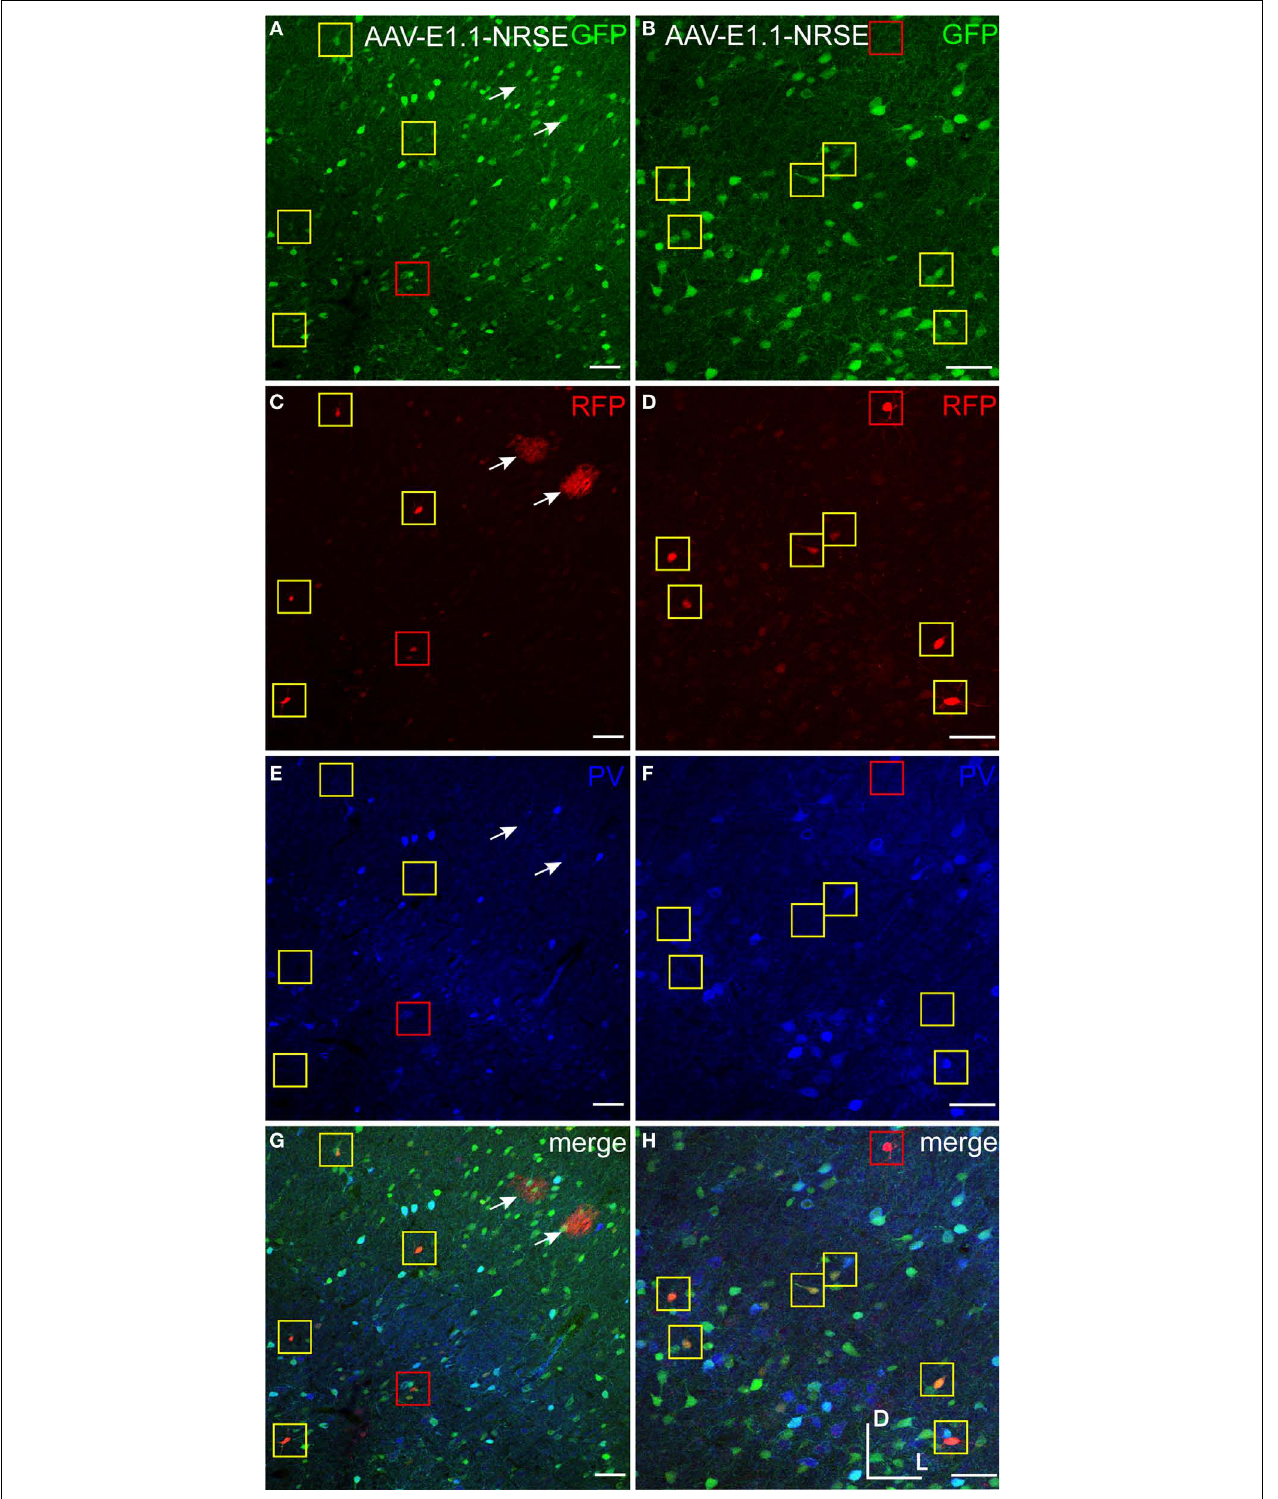
FIGURE 13 | AAV-E1.1-NRSE drove strong expression in a scattered population of cells. AAV with a promoter containing the E1.1 and NRSE motifs (AAV-E1.1-NRSE) was injected into the somatosensory cortex of GAD67-GFP knock-in mice (A,B,G,H) . Expression of the RFP AAV transgene is shown in red